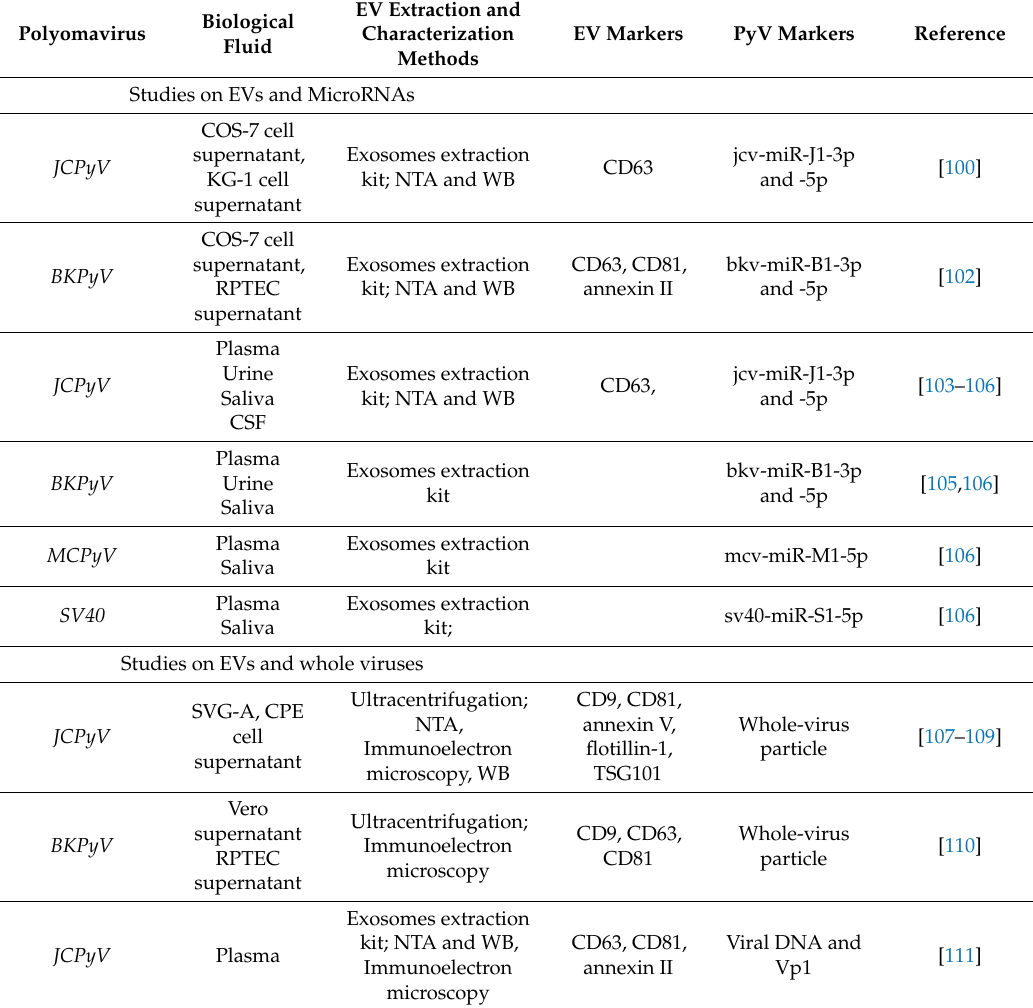
Table 2. Polyomavirus and extracellular vesicles (EVs) reported in